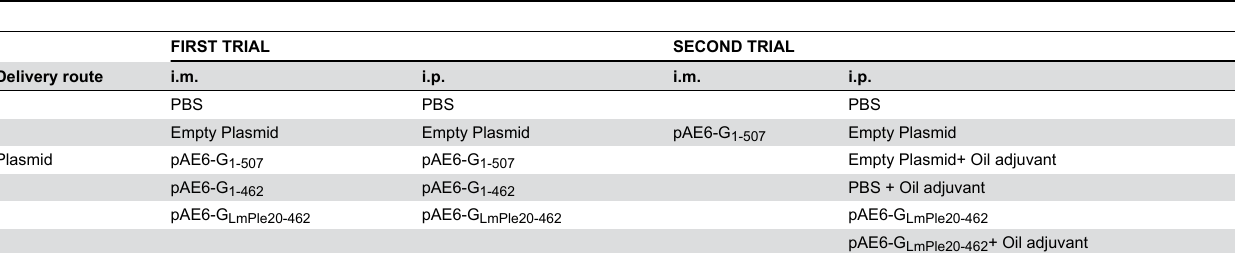
Table 2. Plasmids injected intraperitonealy (i.p.) and intramuscularly (i.m.) into laboratory-reared rainbow